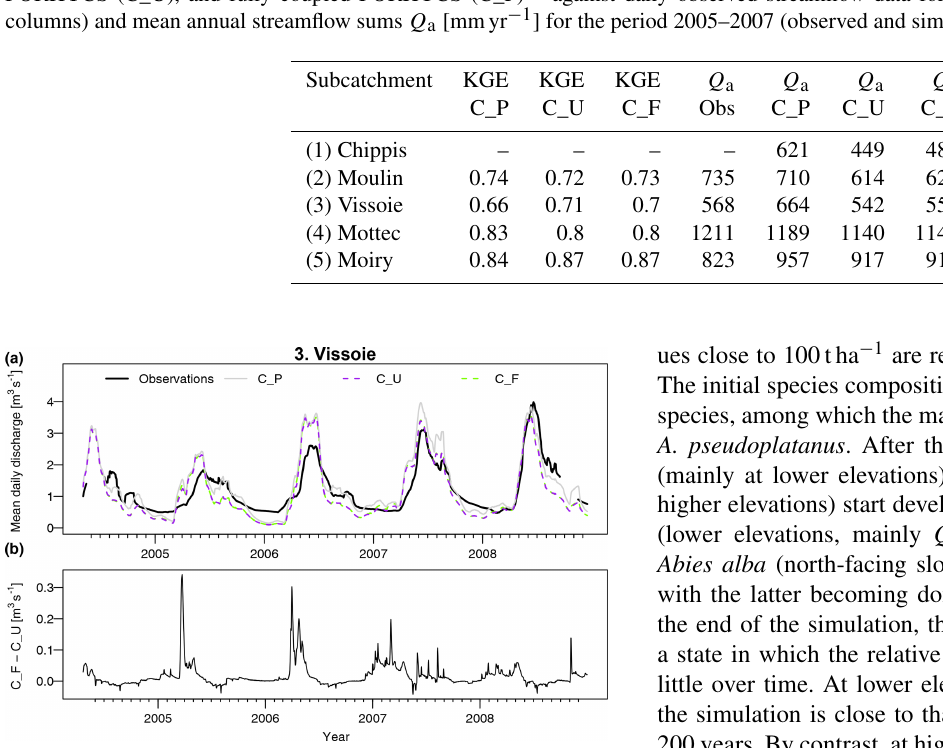
Figure 5. (a) Observed vs. simulated daily streamflow for subcatch- ment 3 (Vissoie) for the period 2004–2008. For clarity, the plot shows rolling averages with a 30d window. The plot shows re- sults for two FORHYCS runs, uncoupled (C_U), and fully coupled (C_F). For reference, the results obtained with standard PREVAH (C_P) are also shown. (b) Difference in simulated daily streamflow between the coupled and uncoupled versions of FORHYCS. Un- like in (a) , values are not shown as rolling averages. Streamflow simulated with coupled FORHYCS is usually higher than for the uncoupled version, and the greatest differences occur in winter and